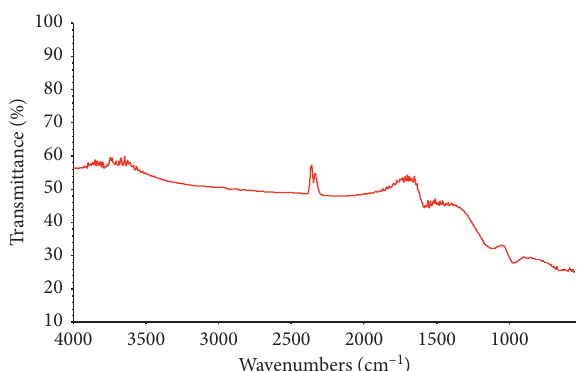
Figure 4: FTIR wavenumbers for synthesised AC (40% H 500 °